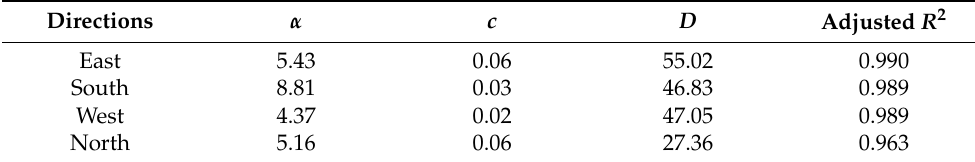
Table 3. Parameters of inversed-S shape function in four directions of São Paulo.